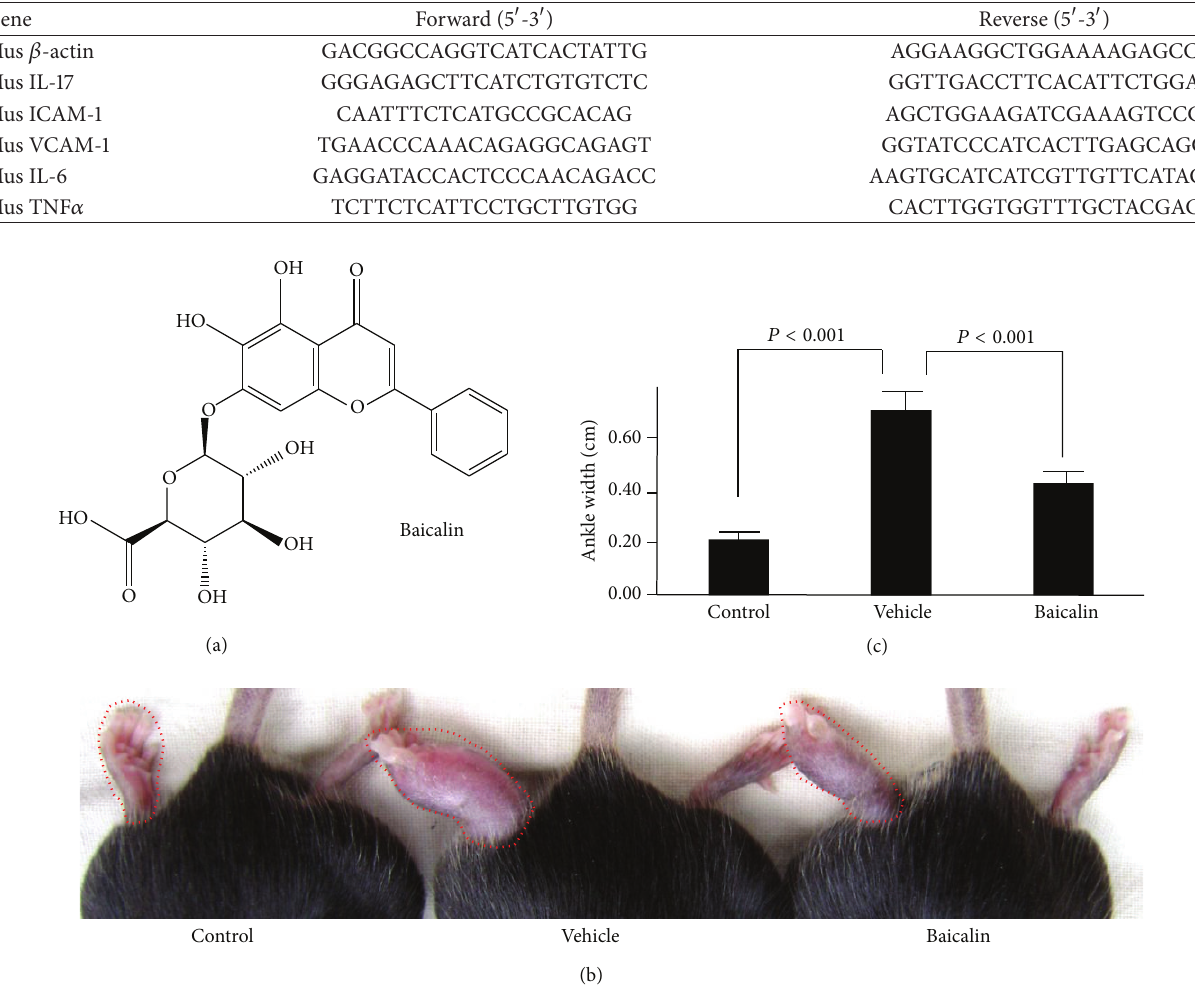
Figure 1: Baicalin alleviates ankle inflammation in a murine adjuvant-induced arthritis model. (a) Chemical structure of Baicalin. (b) Adjuvant-induced arthritis mice were injected intraperitoneally daily with 100mg/kg Baicalin or phosphate-buffered saline (vehicle control) between postimmunization days 14 to 21 and photographs of the swollen ankles were acquired. (c) Ankle widths of the adjuvant-induced arthritis mice ( 𝑛 = 6 for each